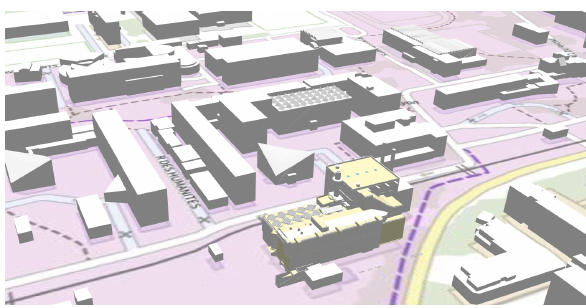
Figure 4. 3D spatial representations : from an Ifc file (in yellow), from CityGML file (in white), stored as